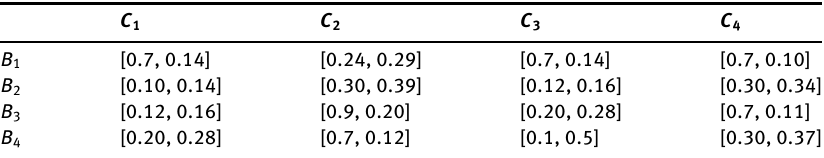
Table 9: Intuitionistic Fuzzy Power Average Aggregation Operator.